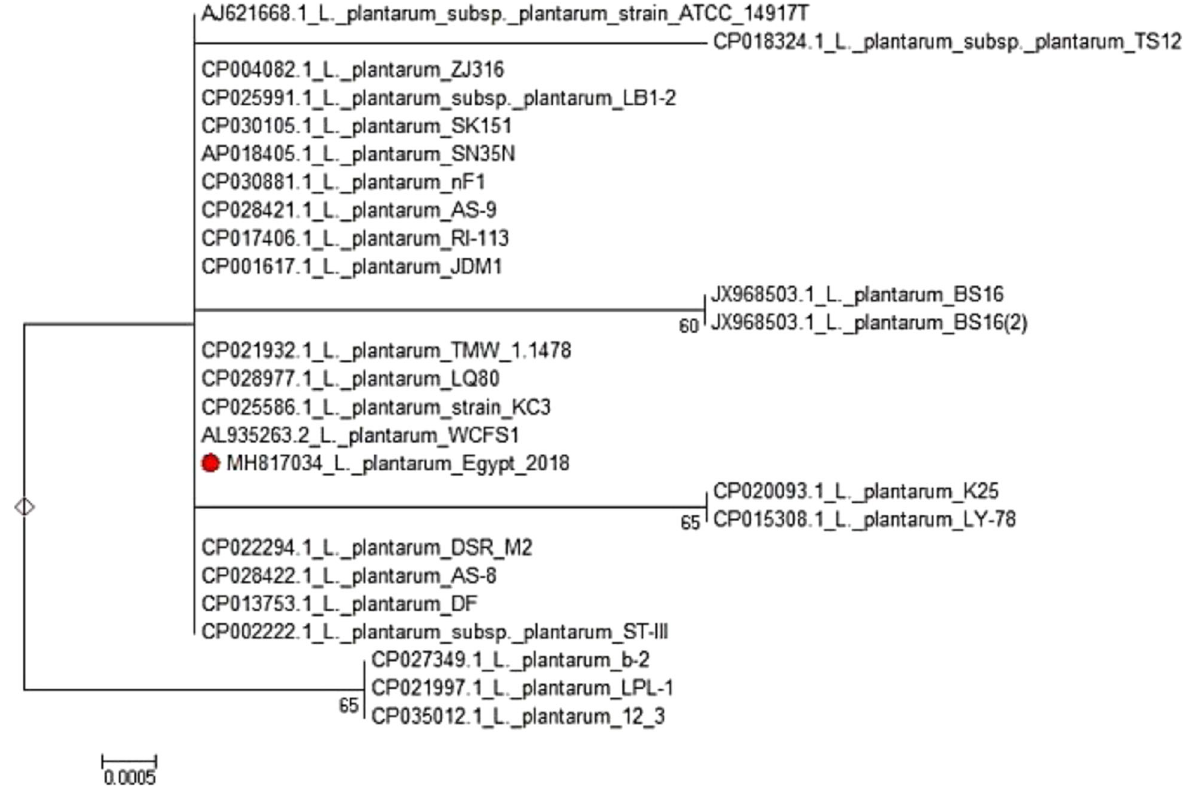
Fig. 3 Phylogenetic tree showing the phylogenetic placement of Lb . plantarum (MH817034) Egypt 2018 as inferred by the neighbor-joining method based on recA gene sequence analyses. Bootstrap values of 1000 replicates are